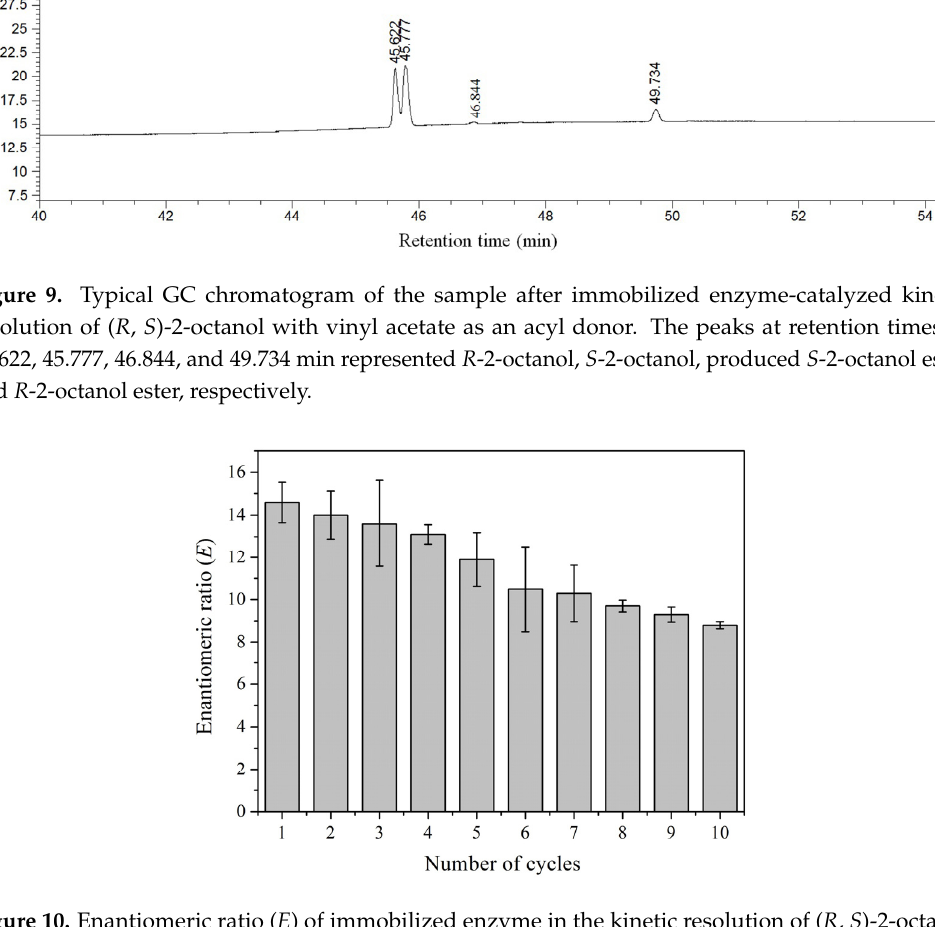
Figure 10. Enantiomeric ratio ( E ) of immobilized enzyme in the kinetic resolution of ( R , S ) ‐ 2 ‐ octanol for different cycles.